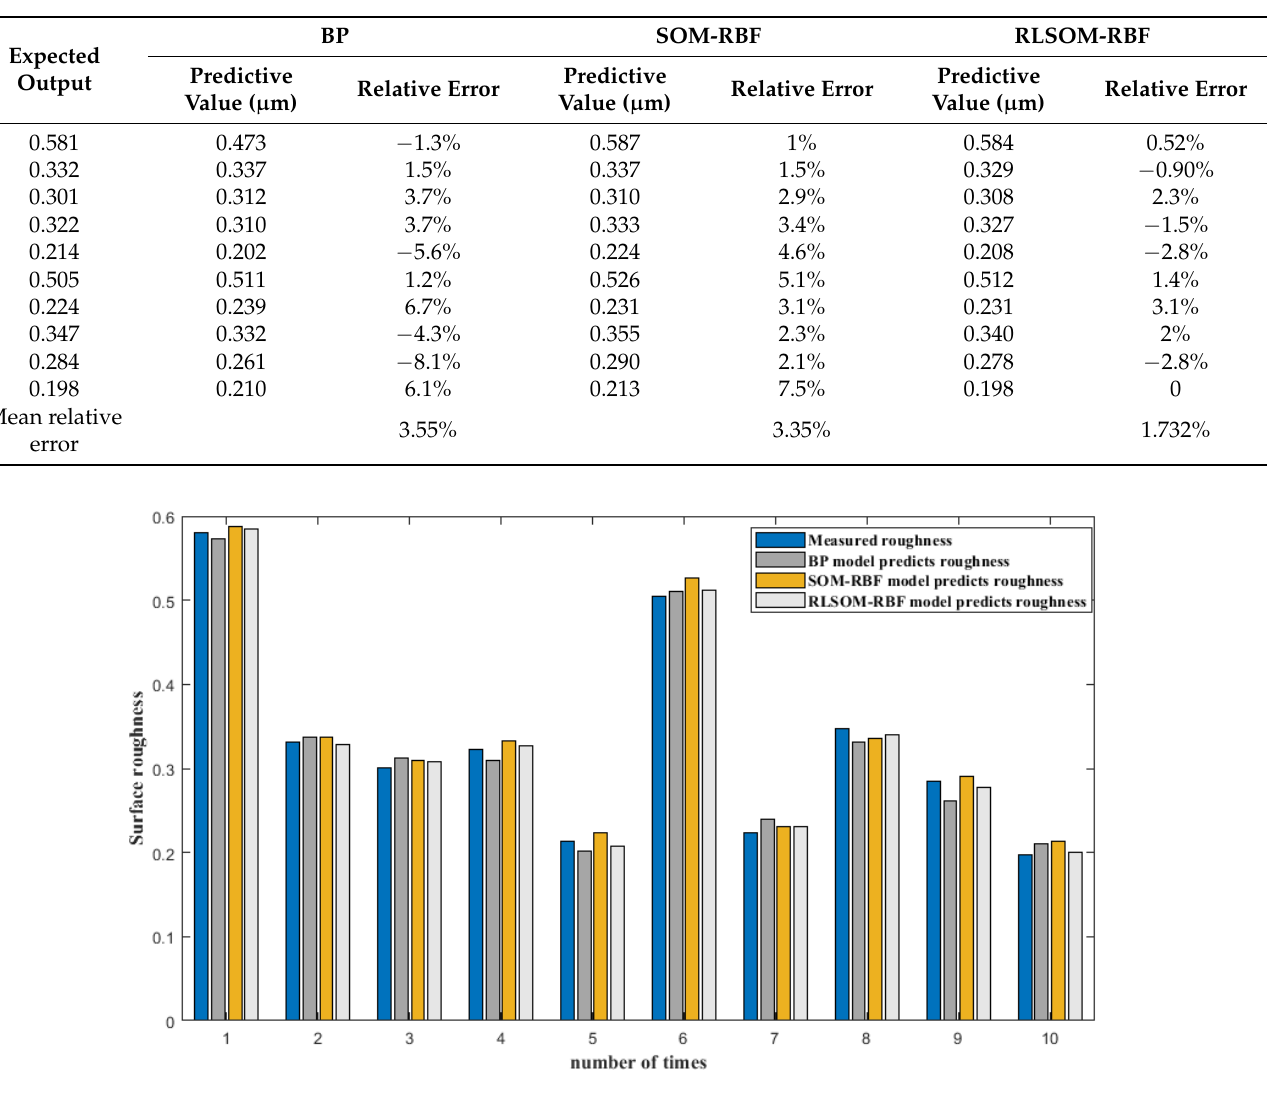
Figure 5. Comparison between experiment and prediction.